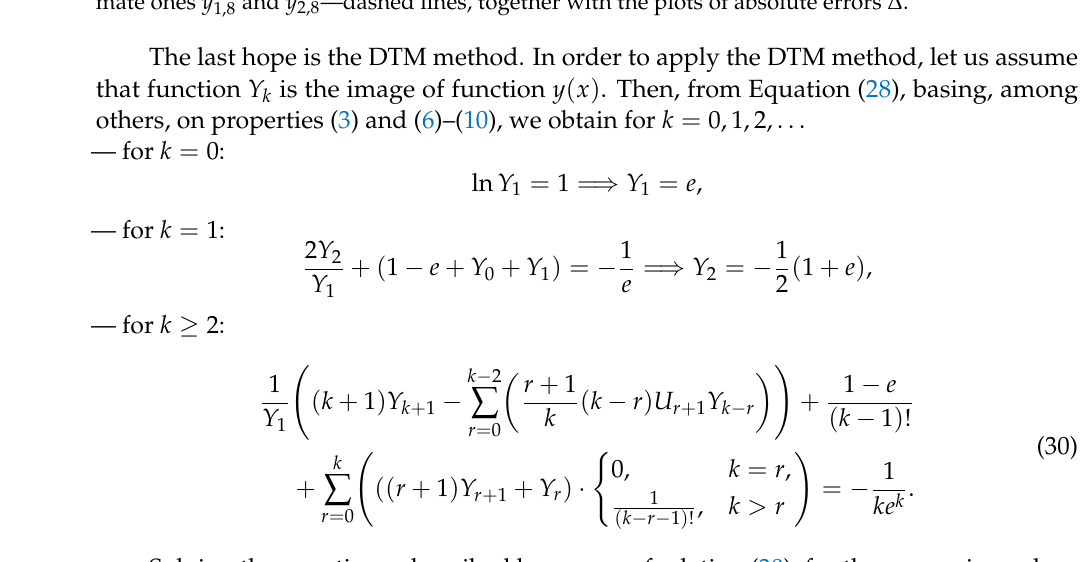
Figure 7. Plots of the solutions of problem (26) and (27): exact ones y 1 and y 2 —solid lines, approxi- mate ones y 1,8 and y 2,8 —dashed lines, together with the plots of absolute errors ∆